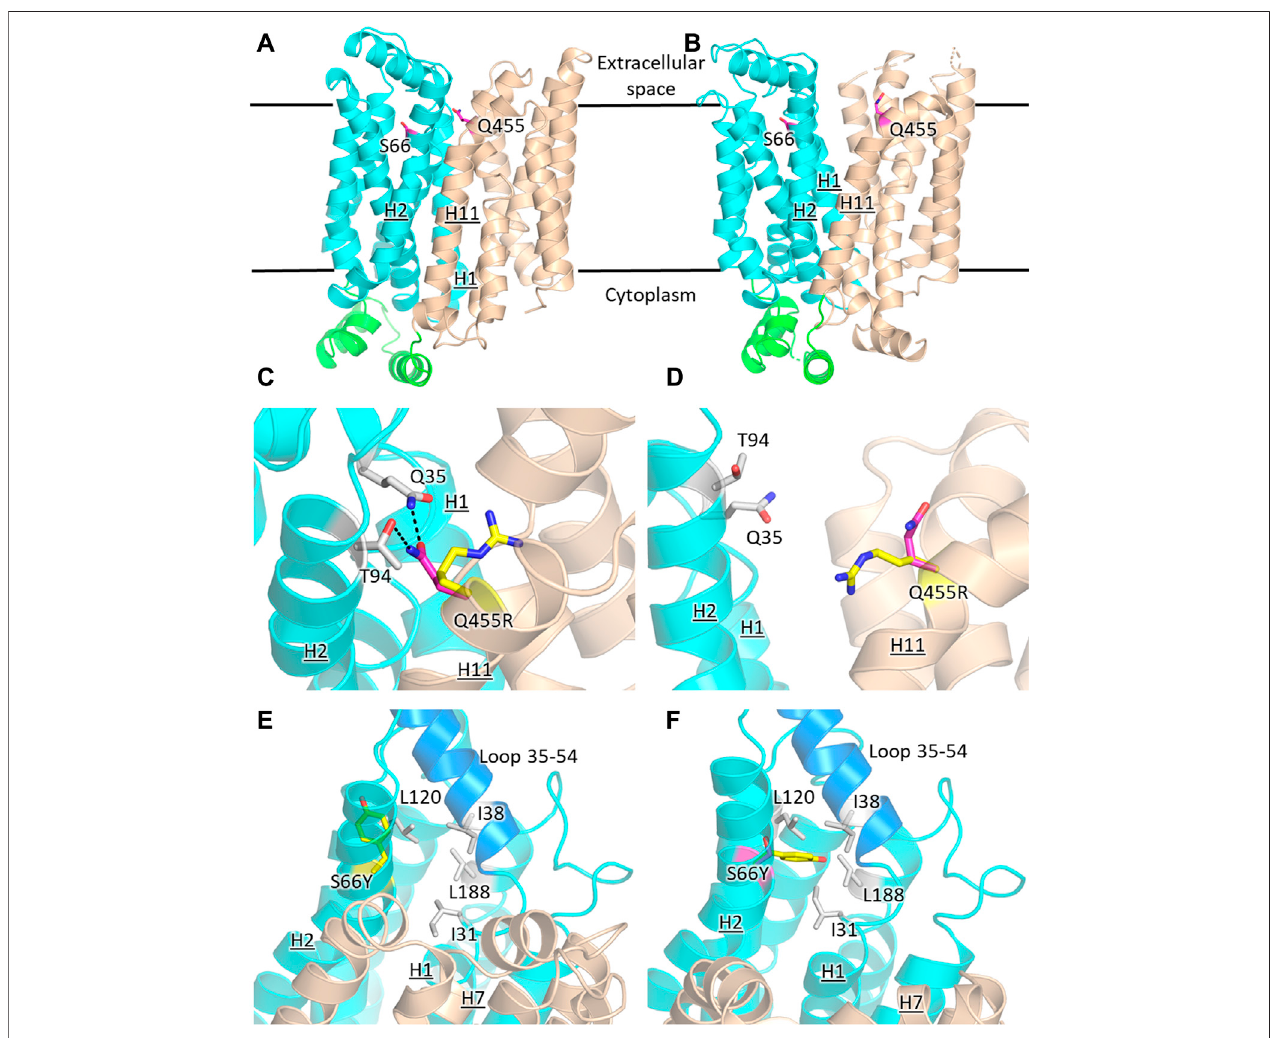
FIGURE6| StructuralmodelsofGLUT2andGLUT3variantswithfunctionaltransporterexpressioninhxt 0 cells.Inward-facing (A,C,E) andoutward-facing (B,D,F) conformations of GLUT2 and GLUT3 based on the crystal structures for the corresponding conformations of GLUT1 (PDB ID 4PYP, inward-facing) or GLUT3 (PDB ID 5C65,outward-facing),showingthelocationsofthesingle-sitemutationsthatincreasedthetransportactivityofGLUT2 loop andGLUT3expressedinhxt 0 yeastcells:S66 inH2ofGLUT3andQ455inH11ofGLUT2 loop .ThetransporterN-andC-halvesareinmagentaandgold,respectively,andthetransmembranehelicesarelabeled as H1-H12. (C,D) Close-up views of (A,B) , respectively, focused on Q455R in GLUT2 loop , showing the original side-chain (magenta), and the mutant (yellow). (E,F) Close-upviewsof (A,B) ,respectively,focused onS66YinGLUT3.Themutant sidechainisshowninyellow.Theextracellularloop betweenhelicesH1and H2(residues 35-54, shown in blue) is close to the mutated side chain Y66 in the outward-facing conformation (F) . Compared with the inward-facing conformation, in the outward- facing conformation, the loop spanning residues 35-54 moves at least 1 Å in the direction indicated by the red arrow. Figures were drawn using Open-Source